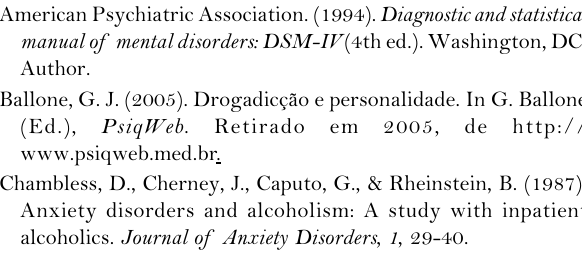
American Psychiatric Association. (1994). Diagnostic and statistical manual of mental disorders: DSM-IV (4th ed.). Washington, DC: